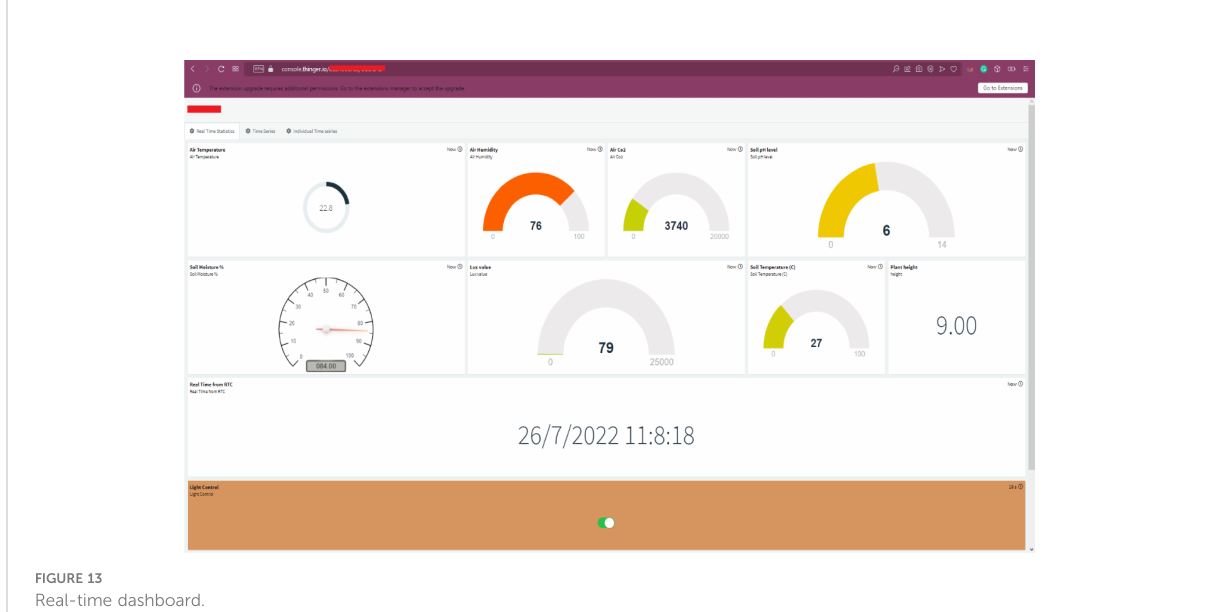
FIGURE 13 Real-time